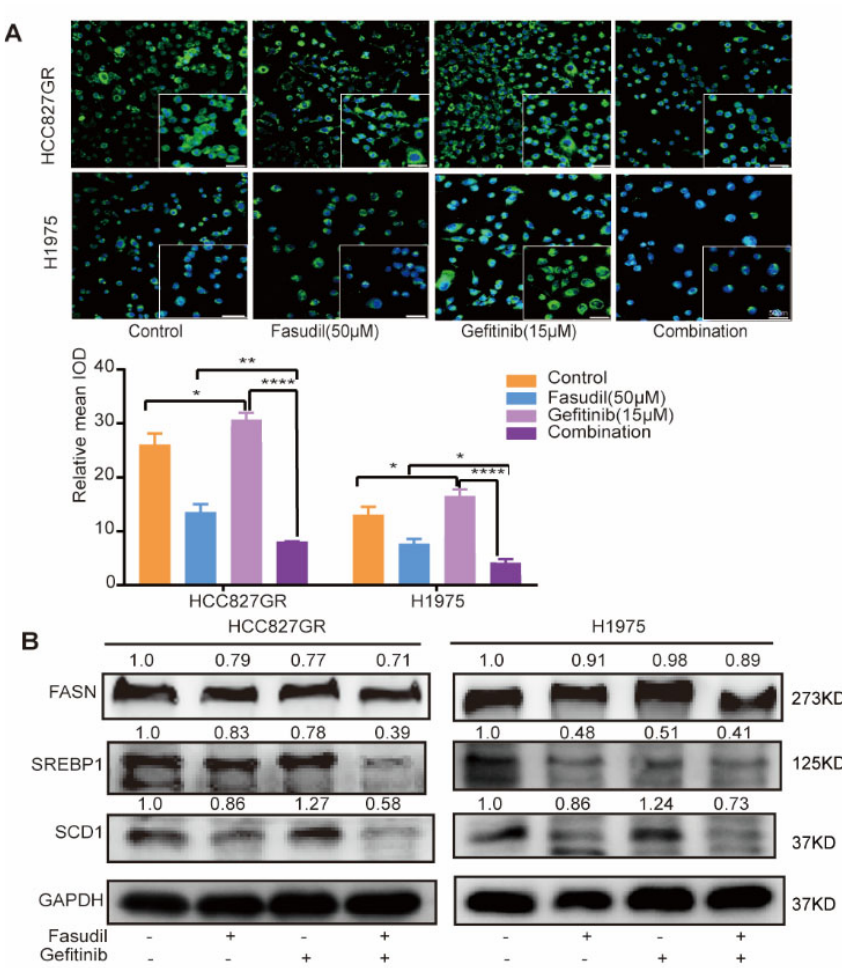
Figure 4. Combined treatment with Fasudil and gefitinib decreases intracellular lipid accumulation in gefitinib ‐ resistant NSCLC cells. ( A ) H1975 and HCC827/GR cells were stained with BODIPY 493/503 (green) and counterstained with DAPI (blue) after 48 h of exposure to control (ddH2O), Fasudil (50 μ M), gefitinib (15 μ M), or Fasudil (50 μ M) + gefitinib (15 μ M). Lipid accumulation of indicated cell lines was evaluated by measuring green fluorescence by Image J. Scale bar: 50 μ m. * p < 0.05, ** p < 0.01 and **** p < 0.0001. ( B ) Western blot analysis of FASN, SREBP ‐ 1, and SCD1 ex ‐ pression in HCC827/GR and H1975 cells treated with control (ddH2O), Fasudil (50 μ M), gefitinib (15 μ M), or Fasudil (50 μ M) + gefitinib (15 μ M) for 48 h. Each gene expression was normalized to glyceraldehyde ‐ 3 ‐ phosphate dehydrogenase (GAPDH). The uncropped blots are shown in Supple ‐ mentary File S1.